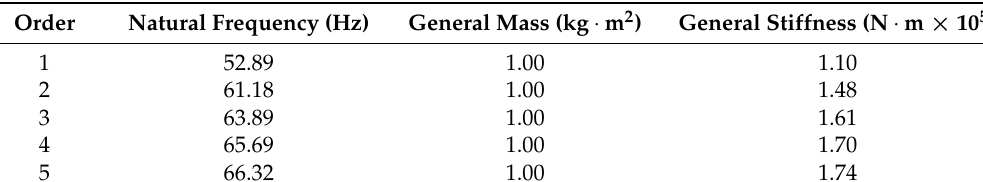
Table A1. Natural frequency, general mass and general stiffness. Order Natural Frequency ( Hz ) General Mass (